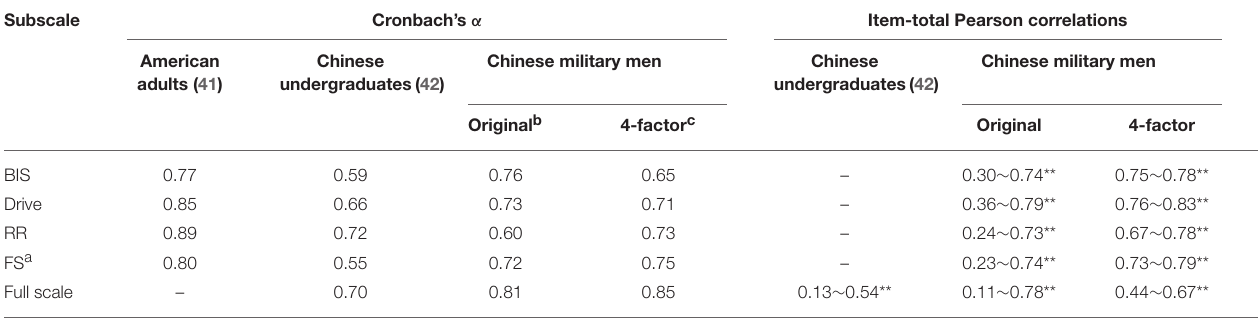
TABLE 2 | Internal consistency and item-total score Pearson correlations for different versions of Behavioral Activation/Inhibition scales